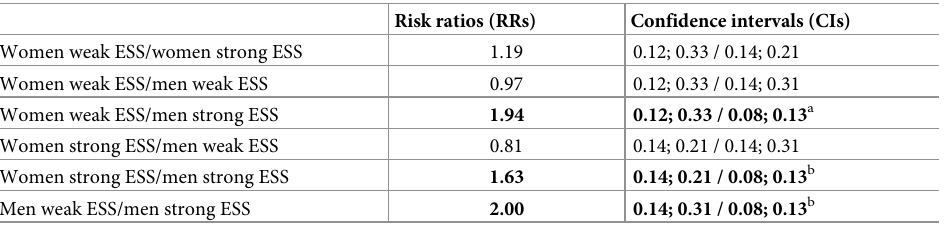
Table 5. Risk ratios (RRs) and confidence intervals (CIs) for frequent pain at follow-up, associated with baseline emotional social support (ESS) among all possible combinations of ESS and sex. Risk ratios (RRs) Confidence intervals